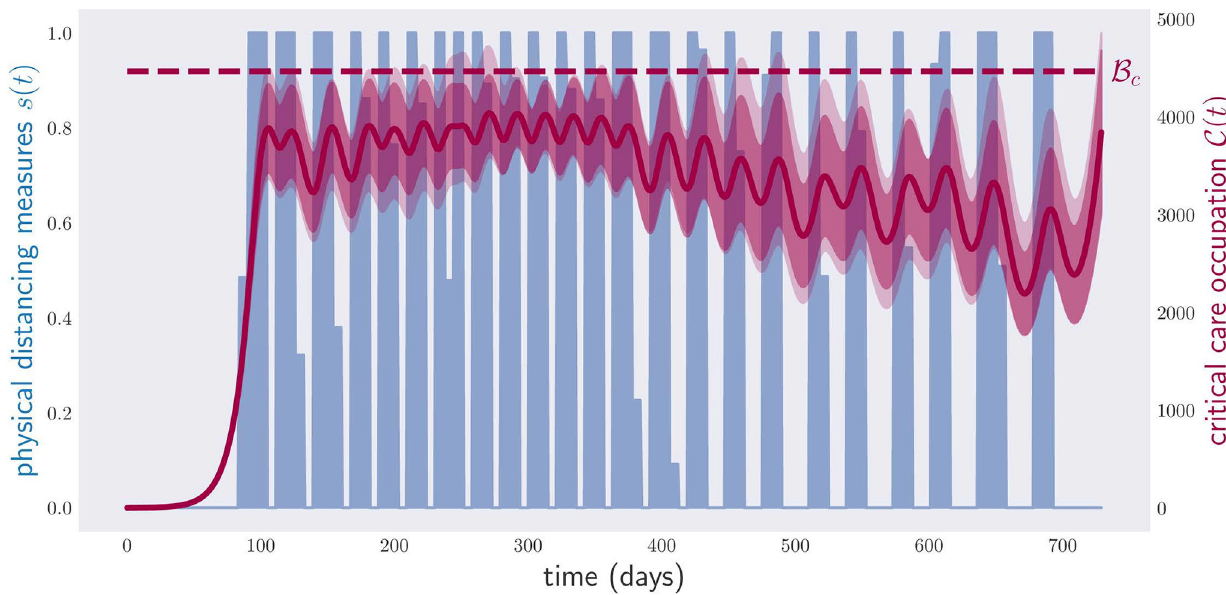
Fig 13. Occupation of critical care beds (red) and physical distancing measures (blue) for a period of two years for stochastic evolution with noise- level η = 0.05. The disease control policy was optimized to respect the condition in Eq (2), i.e., critical care capacity not exceeded. The region in light red depicts the range of critical care occupations observed in a sample of 1000 × η different evolutions, with a stochastic noise η = 0.05; the red line, the average critical care occupation; and the darker red region, the trajectories that lie within two standard deviations from the average value. The policy corresponds to a total of 321 lockdown